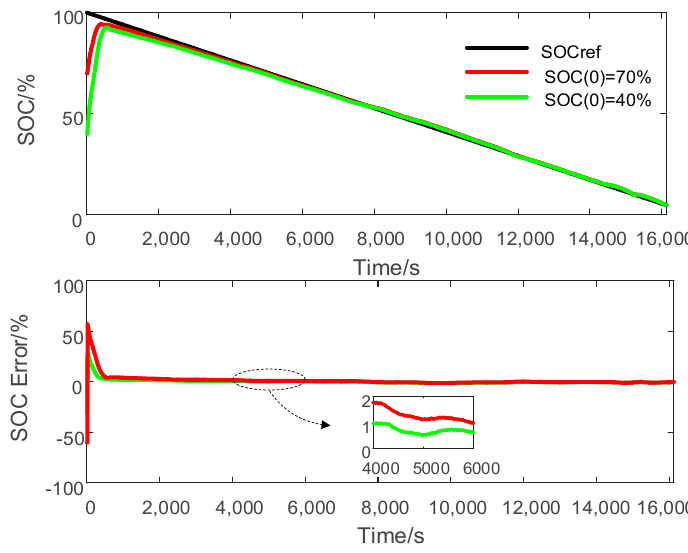
Figure 13. STSMO-based SOC estimation at different initial SOCs